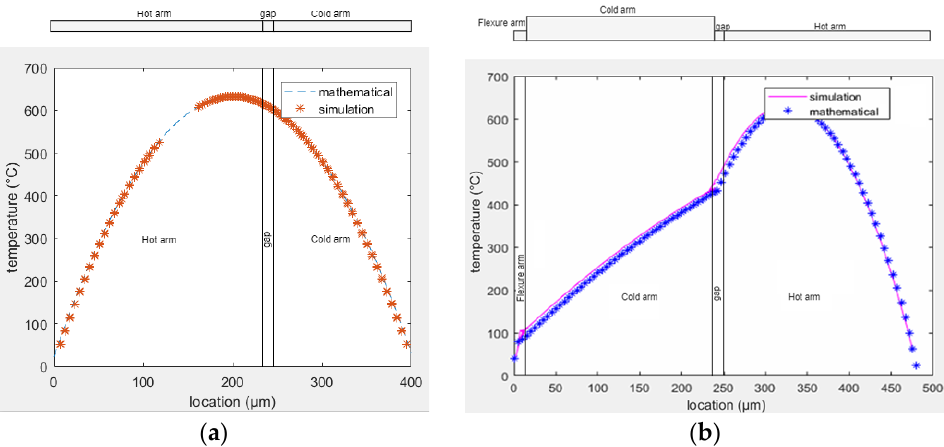
Figure 8. Temperature distribution along electrothermal actuators in: ( a ) design A; ( b ) design B.